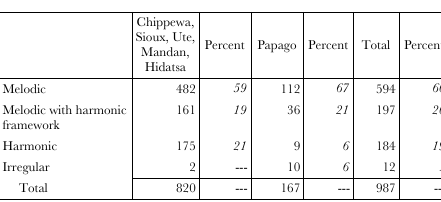
1 Figure 1. Examples of Densmore’s analyses of Native American songs (here Papago songs). ( Top left ): analysis by serial number. ( Top right ): song transcription and commentary. ( Bottom left ): tabular analysis. ( Bottom right ): descriptive analysis ([12], pp. 8, 12, 112,